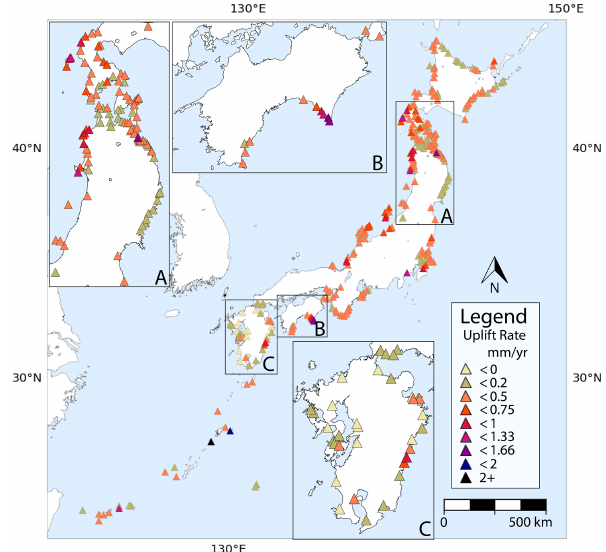
Figure 13. Sea-level proxies uplift rates throughout the Japanese archipelago. Rates of uplift (triangles) are indicated by color (see legend). Expanded views of rates of uplift in northern Honshu and Hokkaido (a) , Shikoku (b) , and Kyushu (c) are